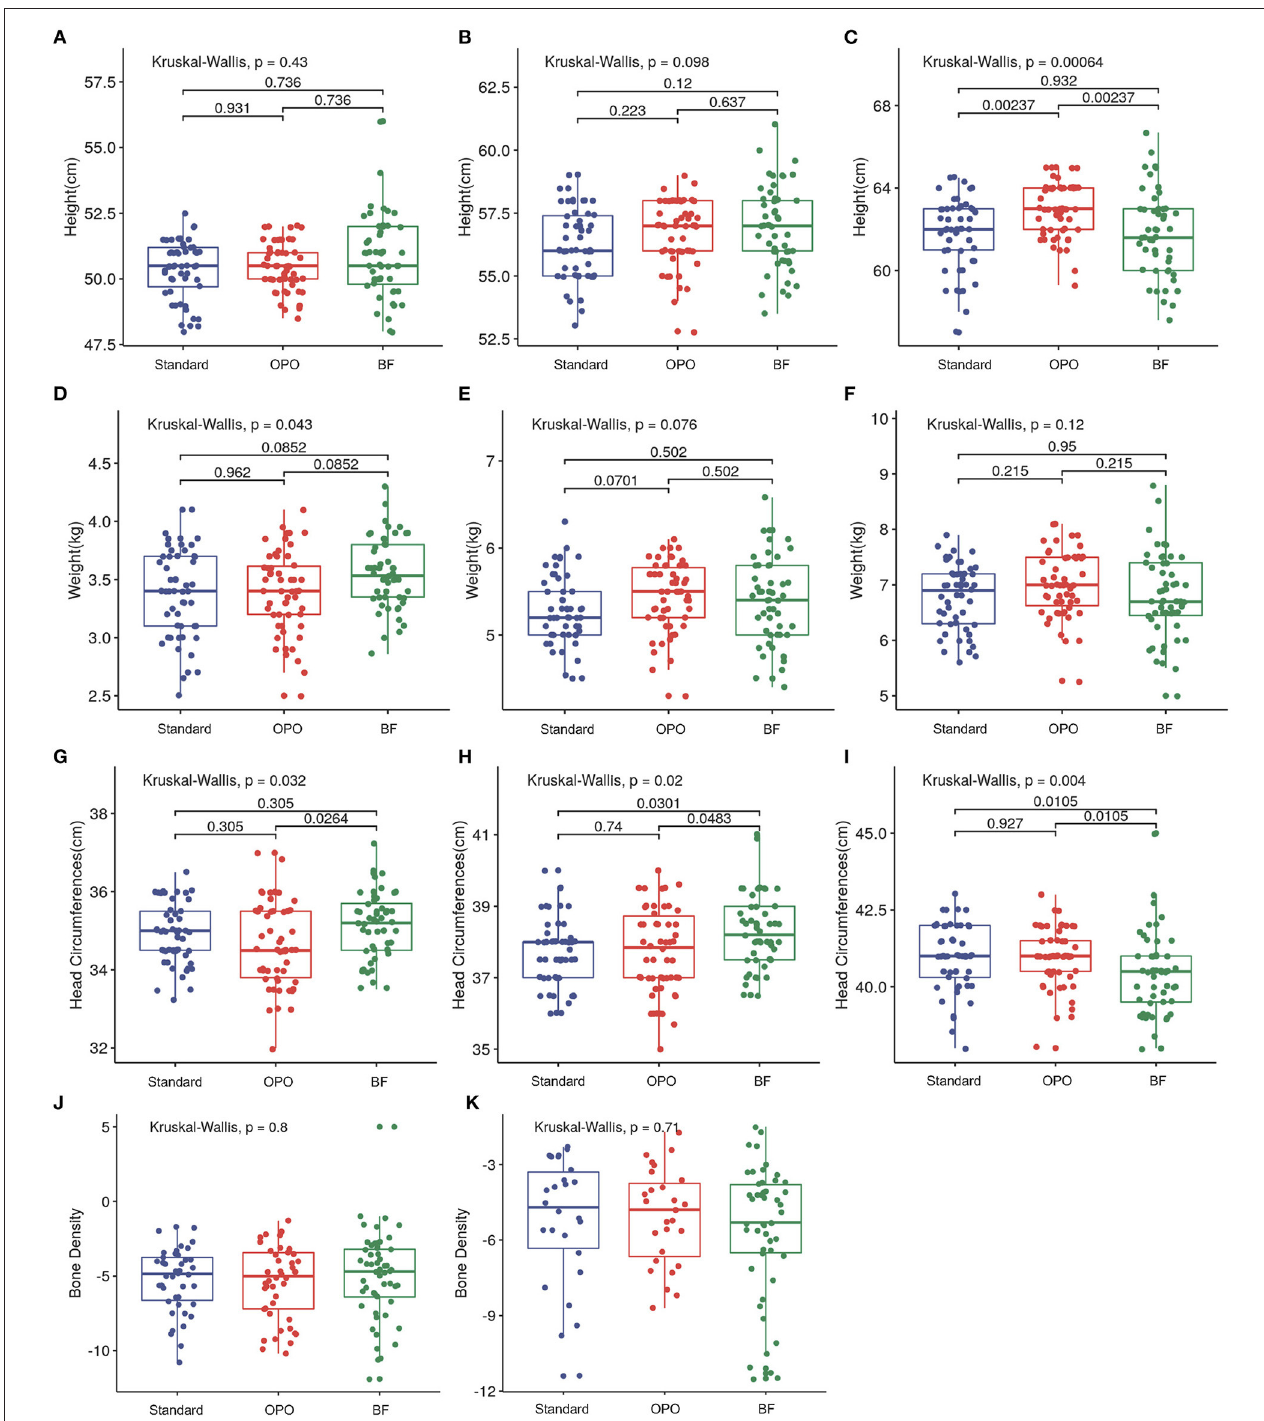
FIGURE 4 | Growth status after feeding among the three study groups. (A–C) Comparison of infant length of different groups at baseline, week 6, and week 12. (D–F) Comparison of infant body weight of different groups at baseline, week 6, and week 12. (G–I) Comparison of head circumference of different groups at baseline, week 6, and week 12. (J,K) Comparison of bone density of different groups at week 6 and week 12. Data are presented as the mean (range). A p -value of less than 0.05 was considered statistically significant.